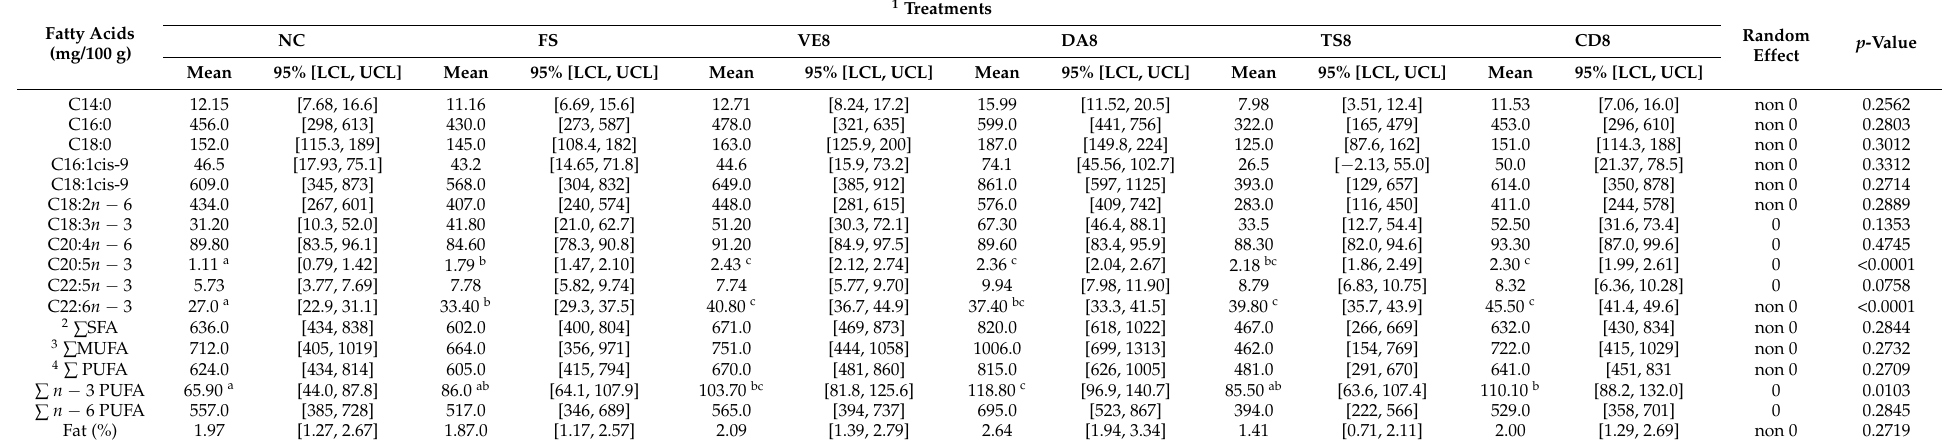
Table 4. Effect of supplementing plant polyphenol extracts and flaxseed on fat content and fatty acid concentration (mg/100 g) in cooked breast muscle of Sasso T451A